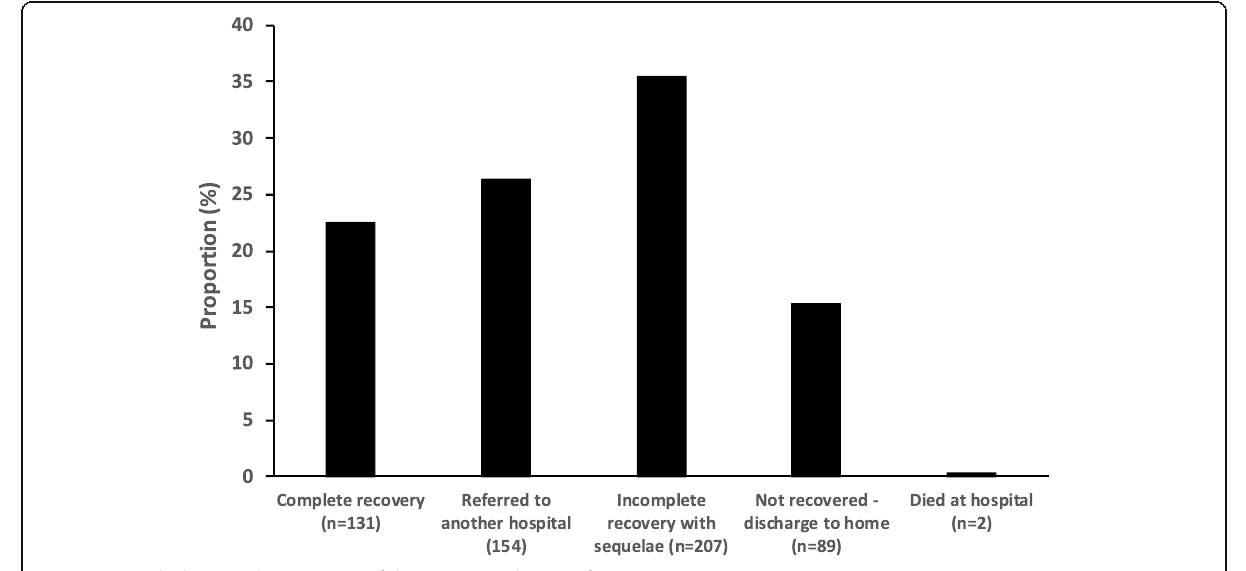
Fig. 2 Bar graph showing the outcomes of the patients with CNS infections ( n =583) Table 2 Distribution of pathogens detected in suspected cases of